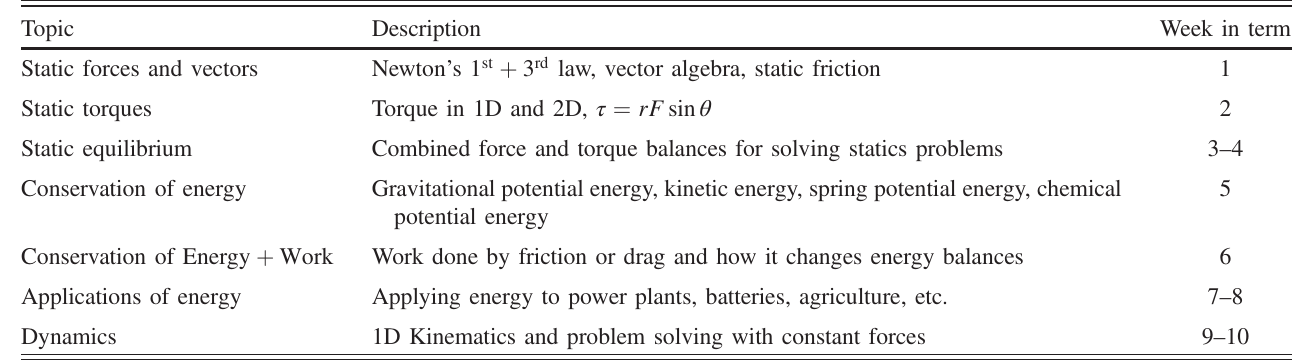
TABLE III. List of topics and course schedule for new course at Stanford. Topic Description Week in term Static forces and